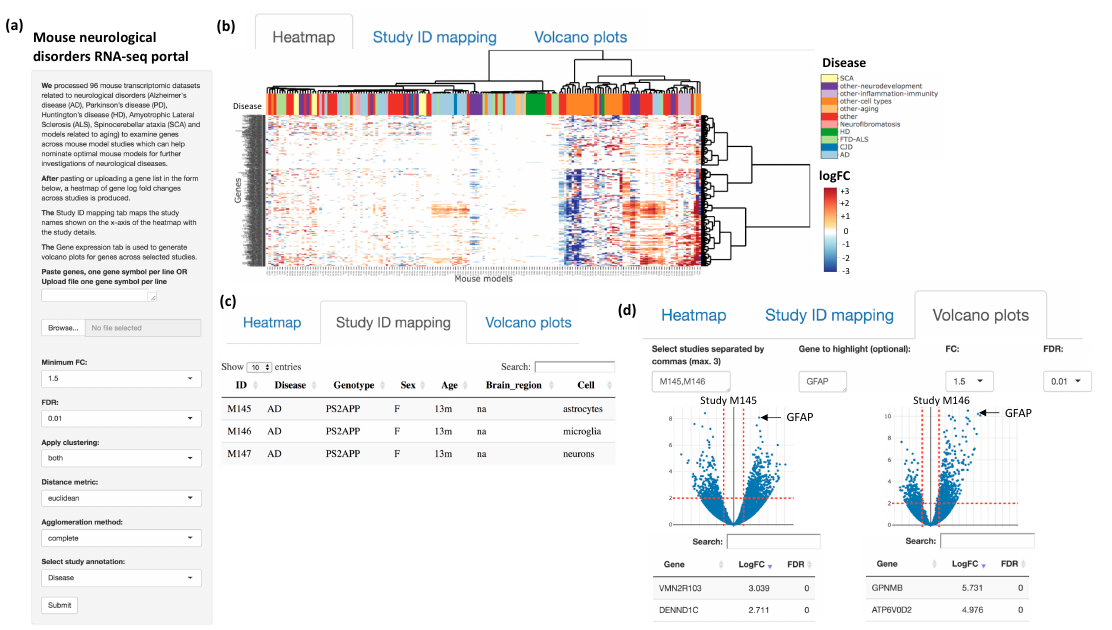
Figure 2. Web interface. ( a ) Users can input a list of genes into the text box or upload a file with a list of genes to study gene expression changes across mouse studies. ( b ) The ‘Heatmap’ tab displays an interactive heatmap with annotations at the top (e.g., disease). ( c ) The ‘Study identifier (ID) mapping’ tab displays a table mapping between the mouse model IDs displayed on the heatmap and the full study annotations. ( d ) The ‘Volcano plots’ tab displays interactive volcano plots where users could compare three studies at a time and highlight a gene of interest. Below each volcano plot, the complete list of genes per study are displayed with their log fold change (FC) and false discovery rate (FDR)